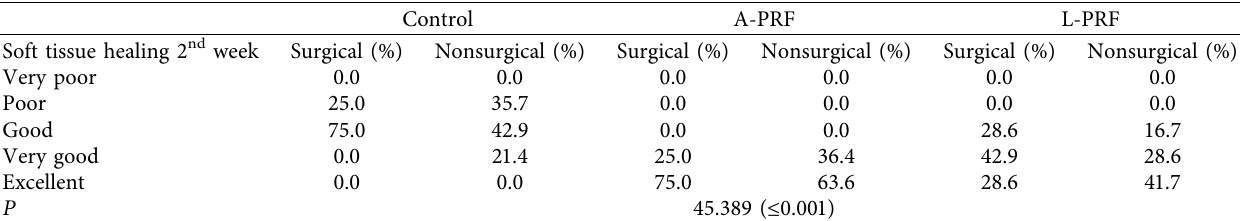
Table 4: Landry Wound Healing Indexes of each group on the first week after tooth extraction. Control